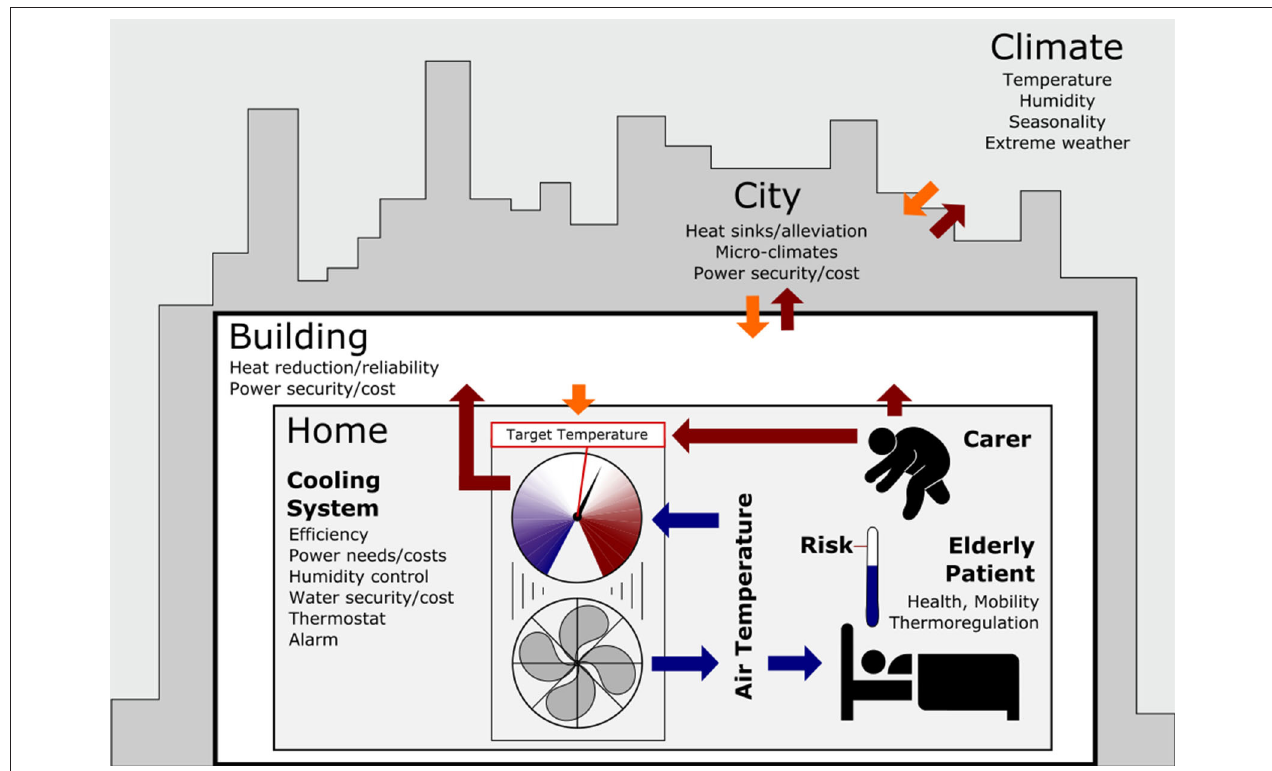
FIGURE 1 | Nested-control system managing the risk of an elderly patient experiencing a heat stroke during home care. Coupled inner systems of thermoregulation in the patient and the cooling system in the home can be regularly monitored and adjusted by a carer. The home environment is impacted by the ambient temperature and humidity of the building, which is the next outer control system. In turn, the building is affected by two further control systems - the temperature and humidity of the city, which is influenced by the regional climate. The identified risk (red line) in the patient thermometer is when the patient’s temperature increases to a critical level at which heat stroke would occur. The cooling system is regulated by the difference in the room temperature and the target temperature (blue-arrow control system). Orange arrows indicate the primary direction of “passive” influence of temperature and humidity from the outer control systems to the inner control systems. Red arrows indicate the “active” feedbacks between these systems when the risk (probability of a temperature causing heat stroke) is unsatisfactory—adjusting the target temperature on the cooling system and the performance of the cooling system are unable to maintain satisfactory room conditions. Factors to consider in each control system are shown in small text. The carer, tenants of the building, building owners, city governors and international governors play critical roles in linking the different control systems through bottom-up and top-down